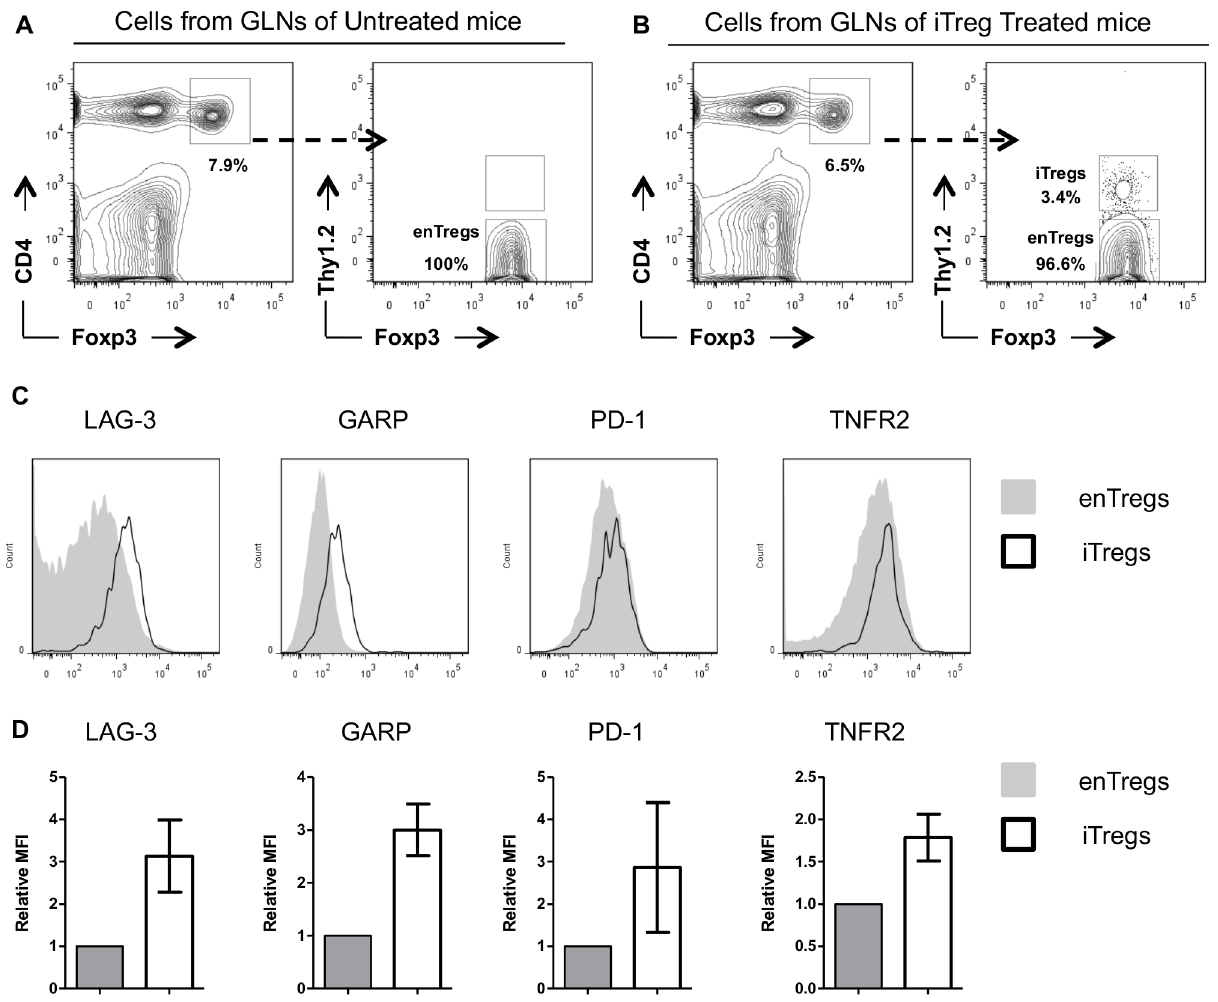
Figure 3. Comparison of inhibitory receptors expressed by enTregs and iTregs. (A–B) Representative flow cytometry plots measuring the percentage Foxp3 + enTregs and adoptively transferred iTregs (Foxp3 + Thy1.2 + ) in the gastric lymph node of untreated and iTreg-treated TxA23 mice. (C) Representative histograms generated using flow cytometric analysis of surface receptors expressed by iTregs (black line) isolated from the gastric lymph nodes TxA23 mice 1 week after treated and enTregs (gray filled line) from age matched untreated TxA23 mice. (D) The mean fluorescent intensity (MFI) of individual receptors expressed by iTregs normalized to the expression by enTregs in individual experiments. Data represents an aggregation of 2–4 individual experiments.